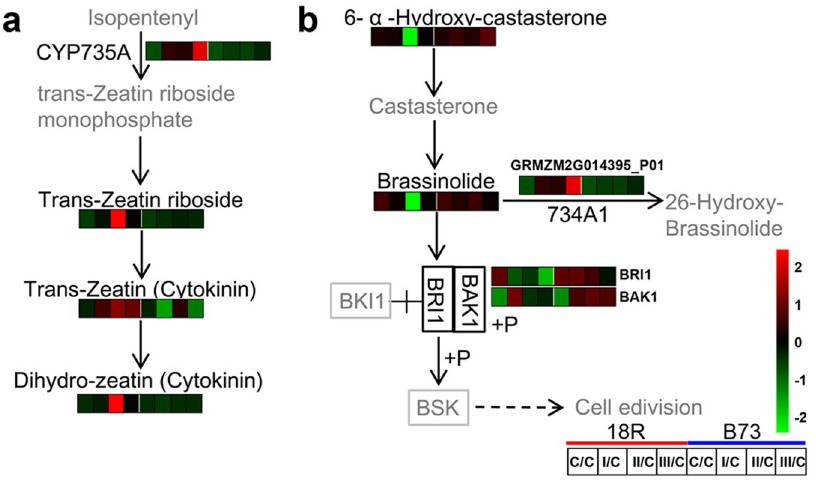
Figure 7. Effects of medium induction on the cytokinin synthesis pathway and the brassinolide synthesis and transduction pathways. The heatmap represents the metabolite and DEP abundance at different stages of 18R and B73. The gray metabolite was not detected or did not significantly